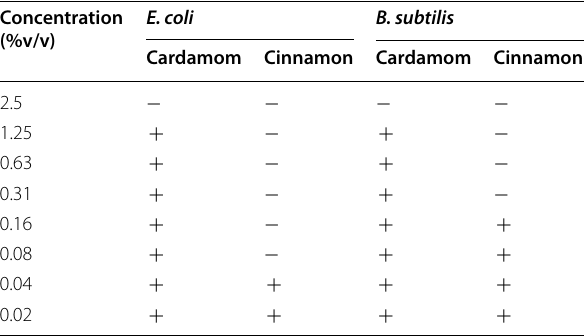
Table 1 MIC values concentration of cardamom and cinnamon essential oils against E. coli and B. subtilis. MIC were evaluated after 24 h of